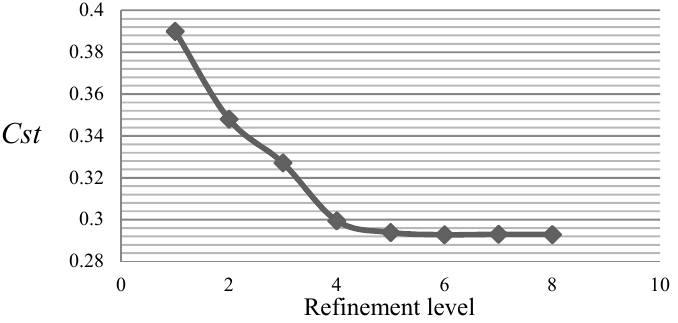
Figure 8. Variation of the static torque coefficient ( Cst ) with different refinement levels.